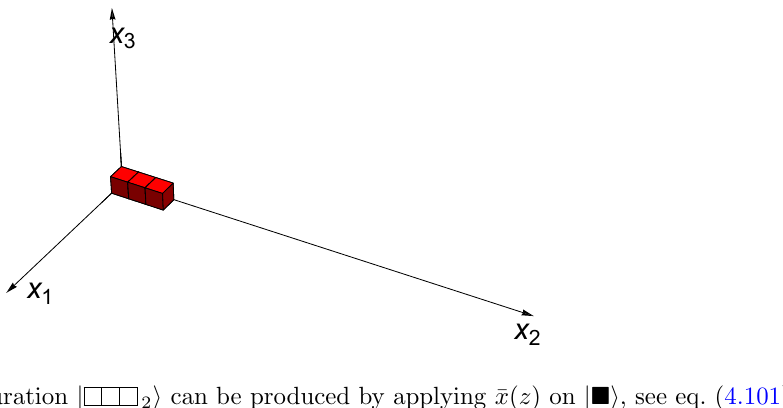
can be produced by applying (cid:22) x ( z ) on j 2 i